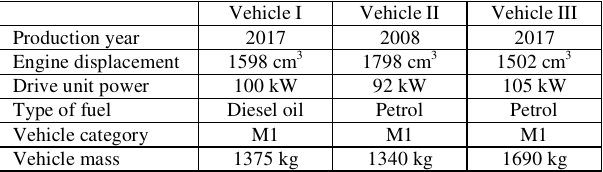
Table 2. Parameters of vehicles used to delineate RDE route Vehicle I Vehicle